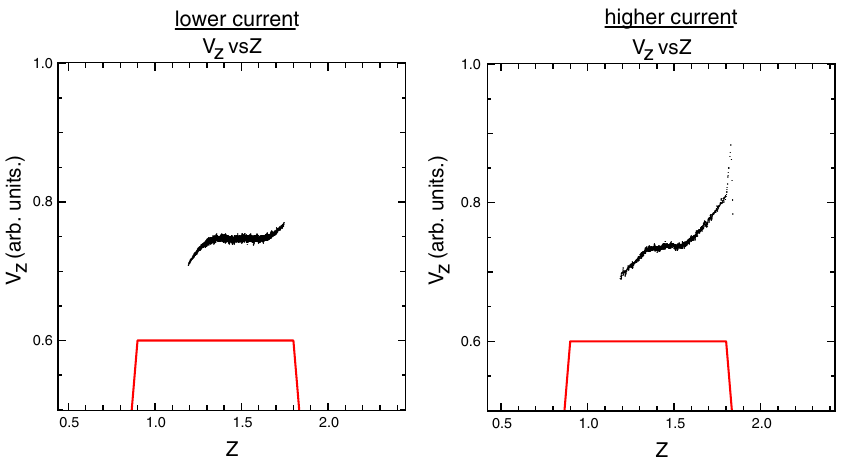
FIG. 5. (Color) The space charge force distorts the phase space of the ion beam. The helix starts at z ¼ 0 : 7 m and ends at z ¼ 1 : 9 m .